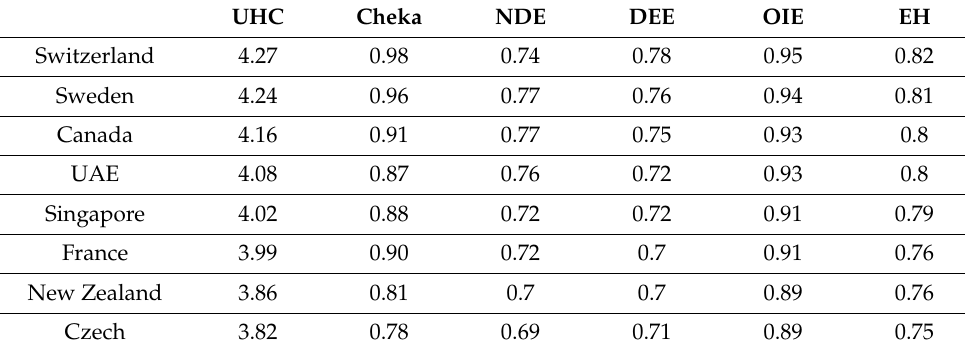
Table 7. Data for calculating the integral indicator of readiness for digitalization of the energy sector of the countries of the 1st group (developed by the authors).